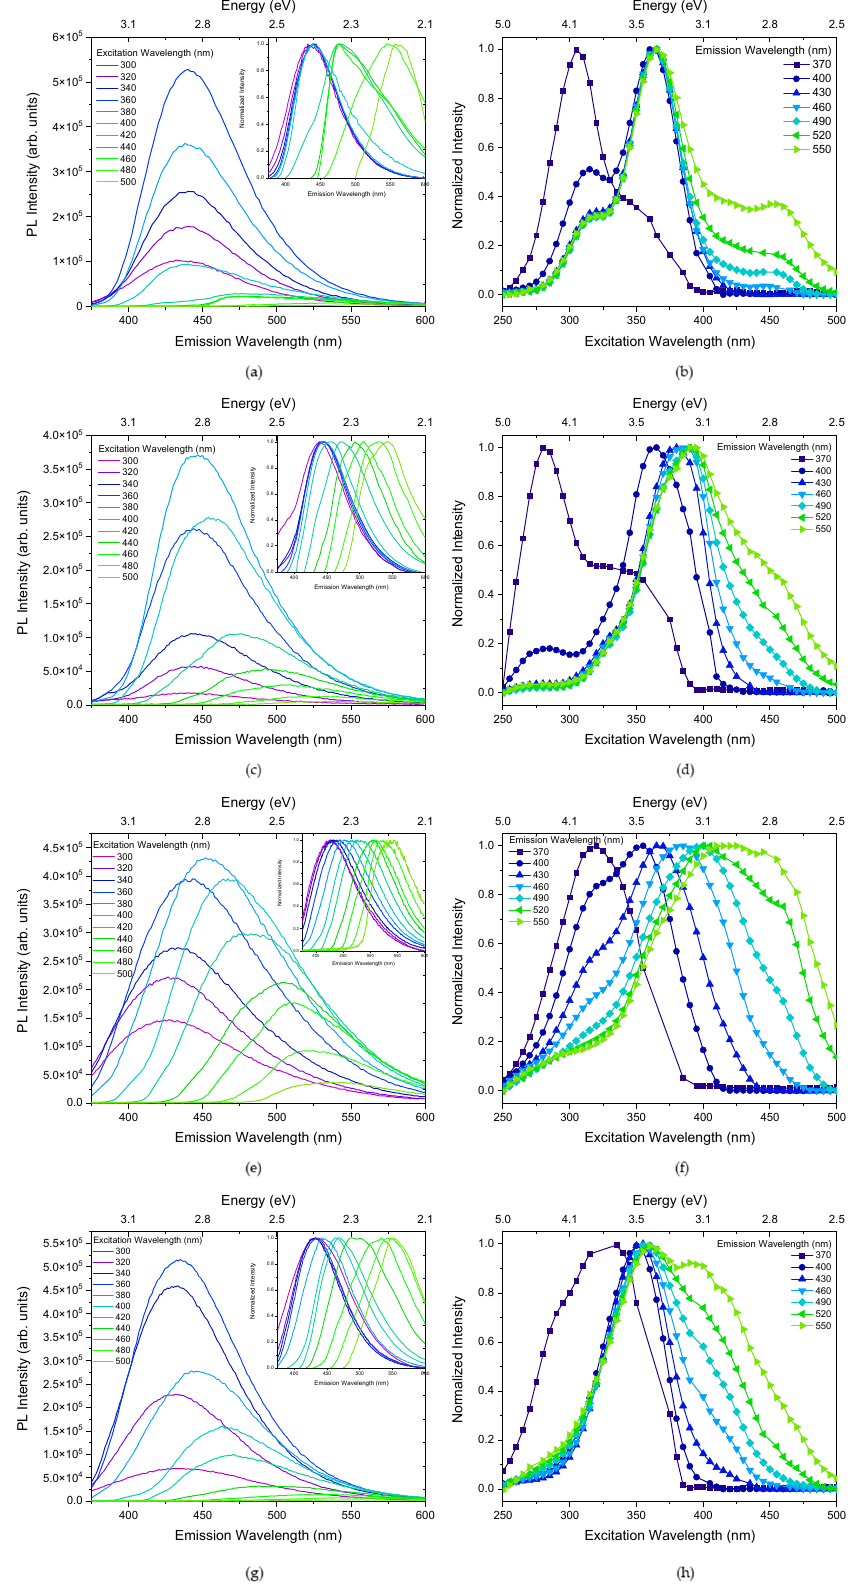
Figure 3. PL and normalized PL (inset) on the left column and normalized PL excitation (PLE) on the right one of CA-urea ( a , b ), CA-Hy ( c , d ), CA-DM-Hy ( e , f ) and CA-P-Hy ( g , h